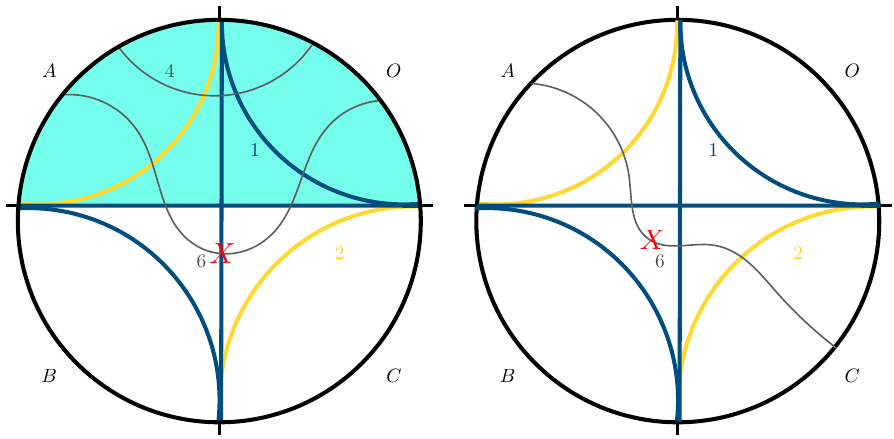
Figure 14 . L: a valid AO 2-thread is shown as it crosses a total barrier of four. By theorem 3 it is able to contribute to a maximal perfect tensor hyperthread configuration. Shown in light blue is the region that such 2-threads can inhabit. This is because any such thread which extended past m BC would necessarily see more than the minimum required barrier of four. This essentially combs the AO 2-threads closer to A and O . R: the barrier configuration explicitly forbids AC 2-threads as there is no way for such a thread to cross exactly a barrier of four. This is consistent with = 0 I ( A : C ) = 2 K AC = 2 µ ∗ AC